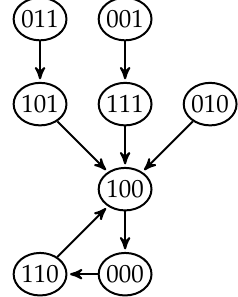
(cid:48) ∨ x ∨ x ∧ x (cid:48) , x 3 ∧ x (cid:48) 2 3 , x 2 1 1